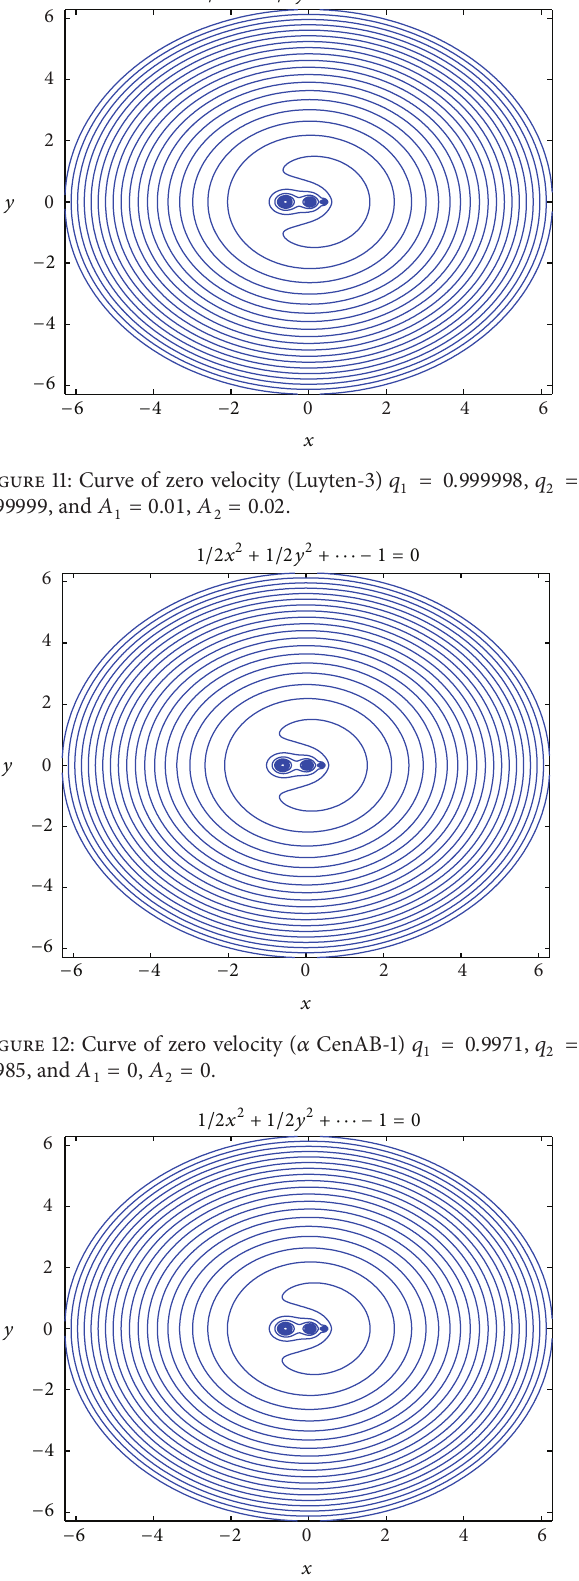
Figure 16: Curve of zero velocity (Kruger60-2) 𝑞 1 = 0.99998 , 𝑞 2 = = 0.01 , 𝐴 = 0.02 0.99996 , and 𝐴 1 2